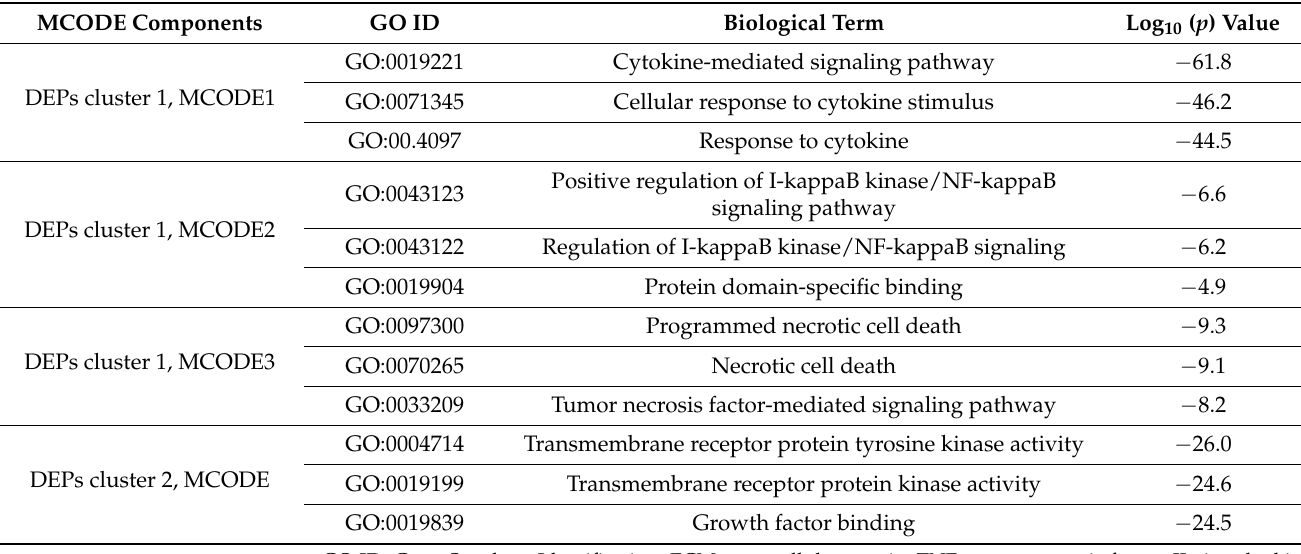
Table 6. Results of Molecular Complex Detection (MCODE) analysis performed on differentially expressed proteins (DEPs) of major dysmood disorder.